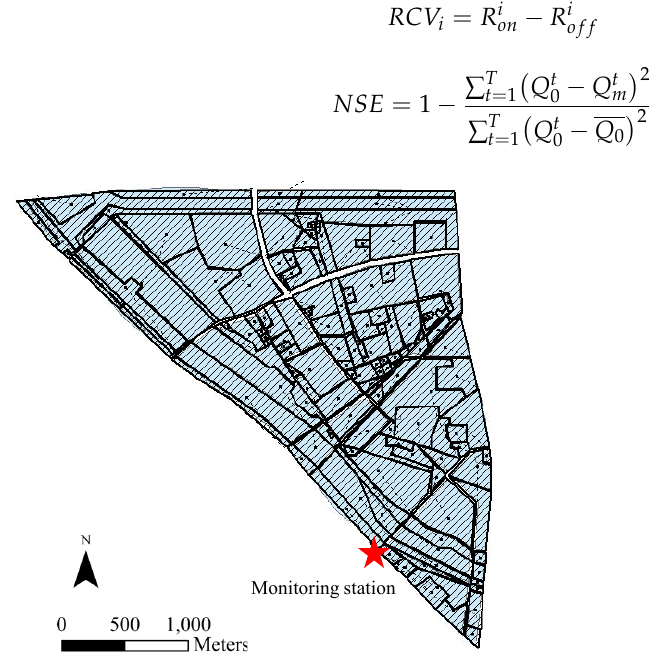
Figure 2. The delta pilot region simulated with the SWMM model.